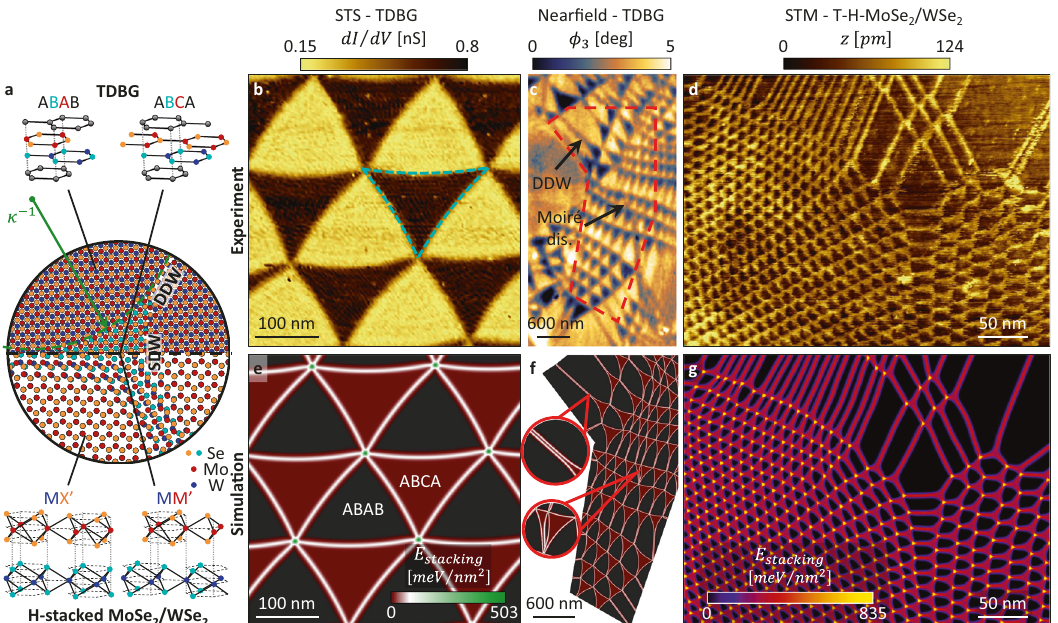
Fig. 1 Physics of atomic layers stacking probed by moiré metrology in vdW twisted bilayers — experiment and theory. a Illustration of domain formations in a relaxed twisted bilayer structure. Center: atomic positioning after relaxation (see Supplementary Information S1 for more details). Atoms are colored